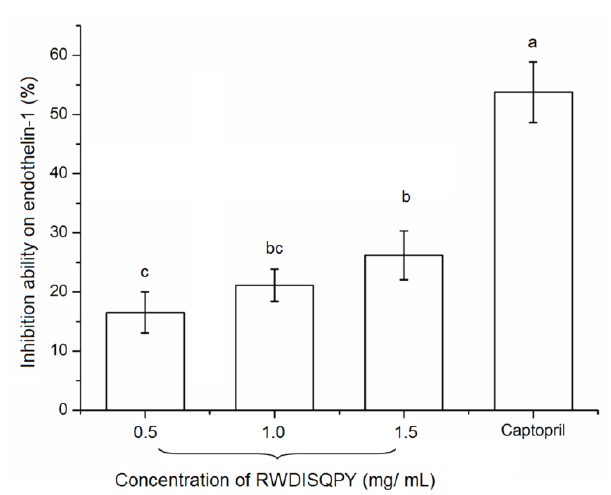
Figure 8. E ff ects of peptide RWDISQPY on intracellular endothelin-1 with captopril (1.0 mg / mL) as a Figure 8. Effects of peptide RWDISQPY on intracellular endothelin-1 with captopril (1.0 mg/mL) as comparison. Di ff erent small letters above the bars (a–c) indicate significant di ff erences ( p < a comparison . Different small letters above the bars (a–c) indicate significant differences ( p < 0.05).